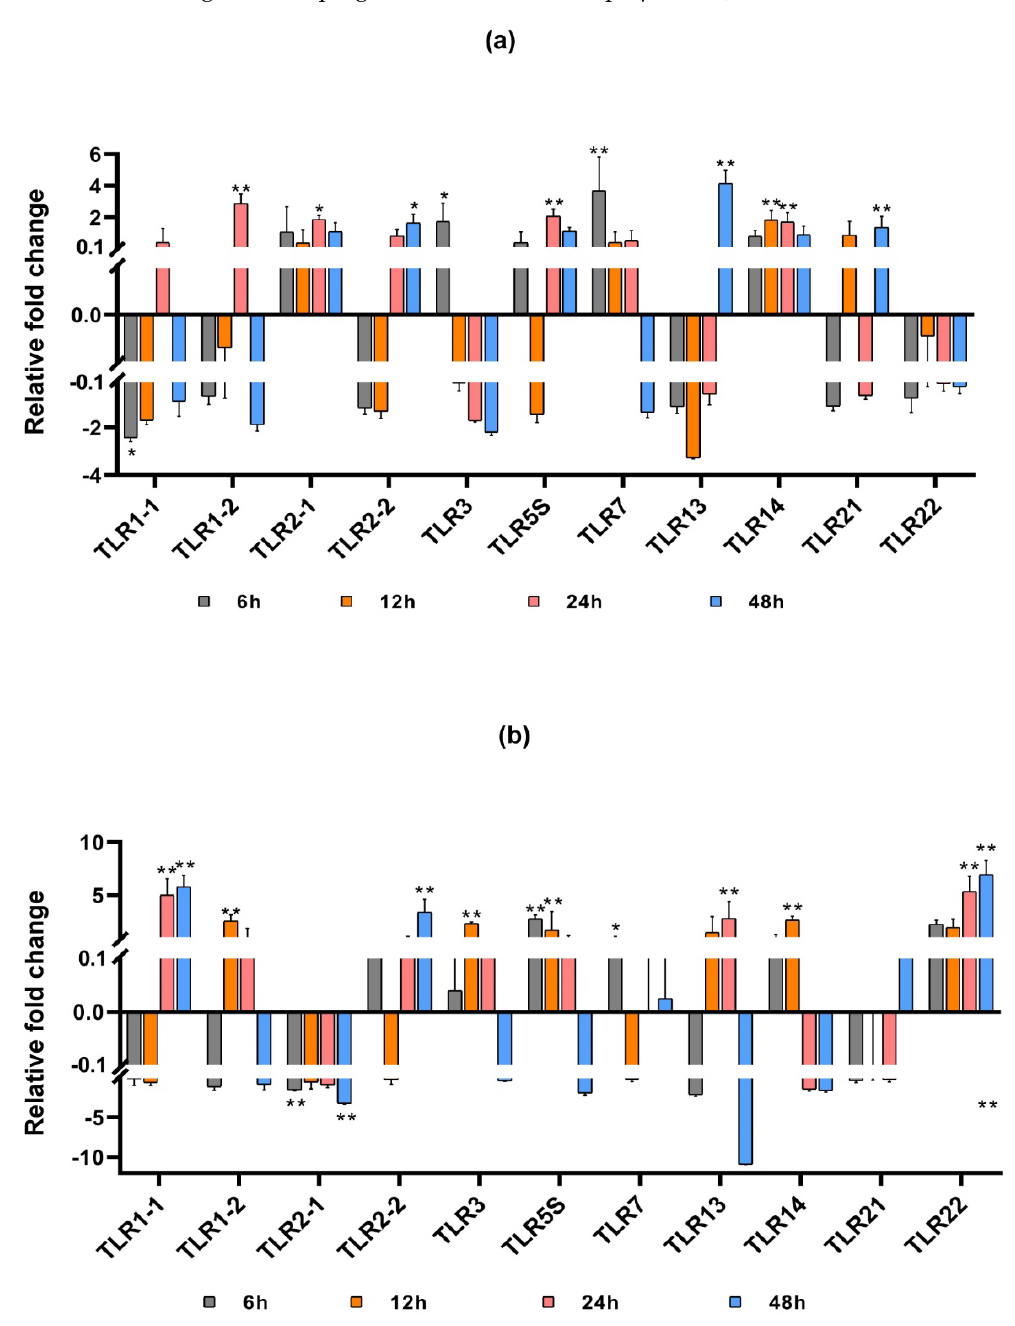
Figure 8. Expression profiles of TLRs in the spleen ( a ) and head kidney ( b ) of marbled rockfish after poly(I:C) injection. The relative gene expression levels of SmaTLRs were normalized with β -actin. Asterisks indicated statistical significance ( p < 0.05, *) or extremely statistical significance ( p < 0.01, **) of up-/downregulation of the genes between the treated group and the control at the given time point.